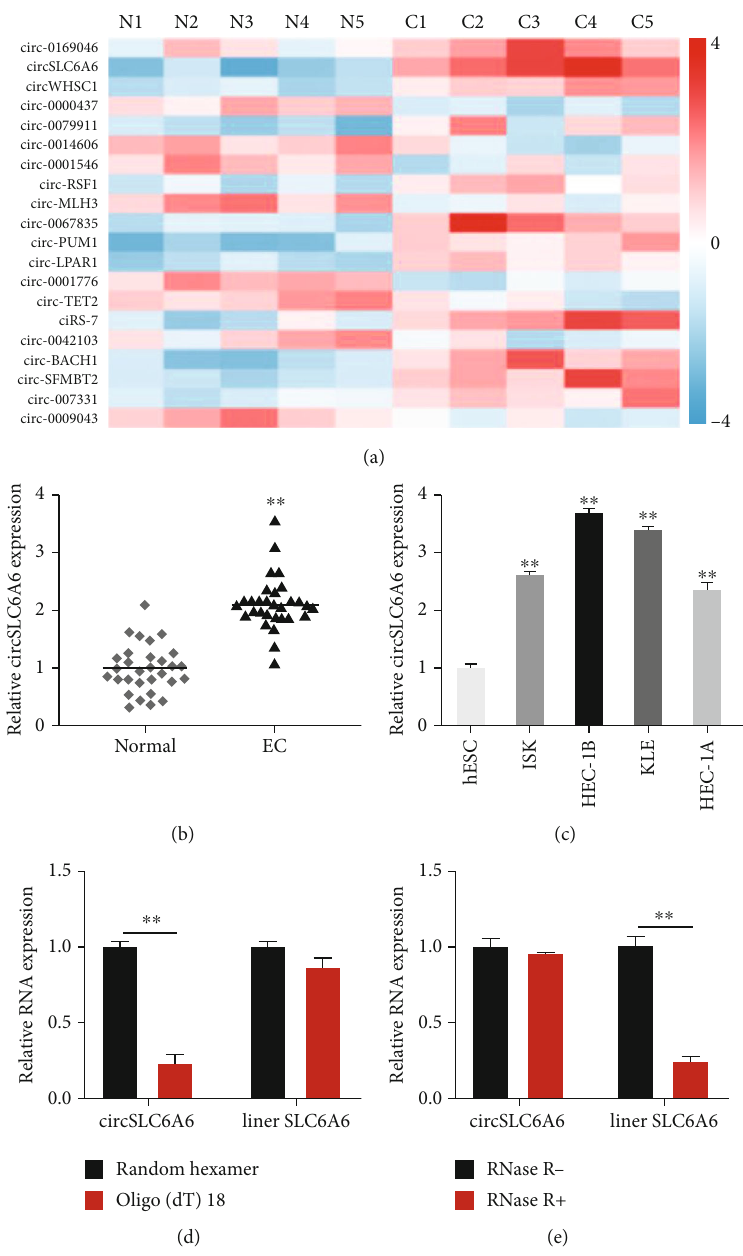
Figure 1: circSLC6A6 is upregulated in endometrial cancer: (a) the heat map of dysregulated circRNAs in 5 endometrial cancer tissues using circRNA sequencing; (b) the expression of circSLC6A6 in 30 pairs of EC tissues and matched normal tissues by qRT-PCR; (c) the expression of circSLC6A6 in EC cell lines by qRT-PCR; (d) the expressions of circSLC6A6 and linear SLC6A6 ampli fi ed by random hexamer and oligo(dt)18; (e) the expressions of circSLC6A6 and linear SLC6A6 after RNase R treatment ( ∗∗ p < 0 : 01 2.12. Xenografts in Mice. All 12 male BALB/c nude mice (four- 2.11. Western Blot. EC cells were lysed by RIPA bu ff er contain- week-old, 18-20g) were obtained from the Wuhan Center for ing protease inhibitor. Total protein extracted from EC cells was separated by sodium dodecyl sulphate-polyacrylamide gel elec- Disease Control and Prevention. 1 × 10 7 HEC-1B cells stably trophoresis and transferred to polyvinylidene fl uoride (PVDF) membranes (Millipore, USA). The membranes were blocked with 5% skimmed milk and incubated with the primary anti- bodies (1:1000, Abcam, USA) overnight at 4 ° C. The secondary antibodies (1:10000, Abcam, USA) were incubated for 1h at room temperature. Then, the Clarity Western ECL Substrate (Bio-Rad, USA) was used to visualize the protein bands.